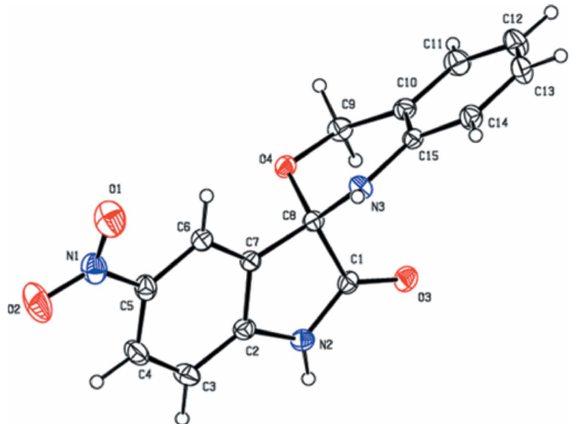
Figure 1 The molecular structure of the title molecule, with the atom labelling. Displacement ellipsoids are drawn at the 30% probability level.